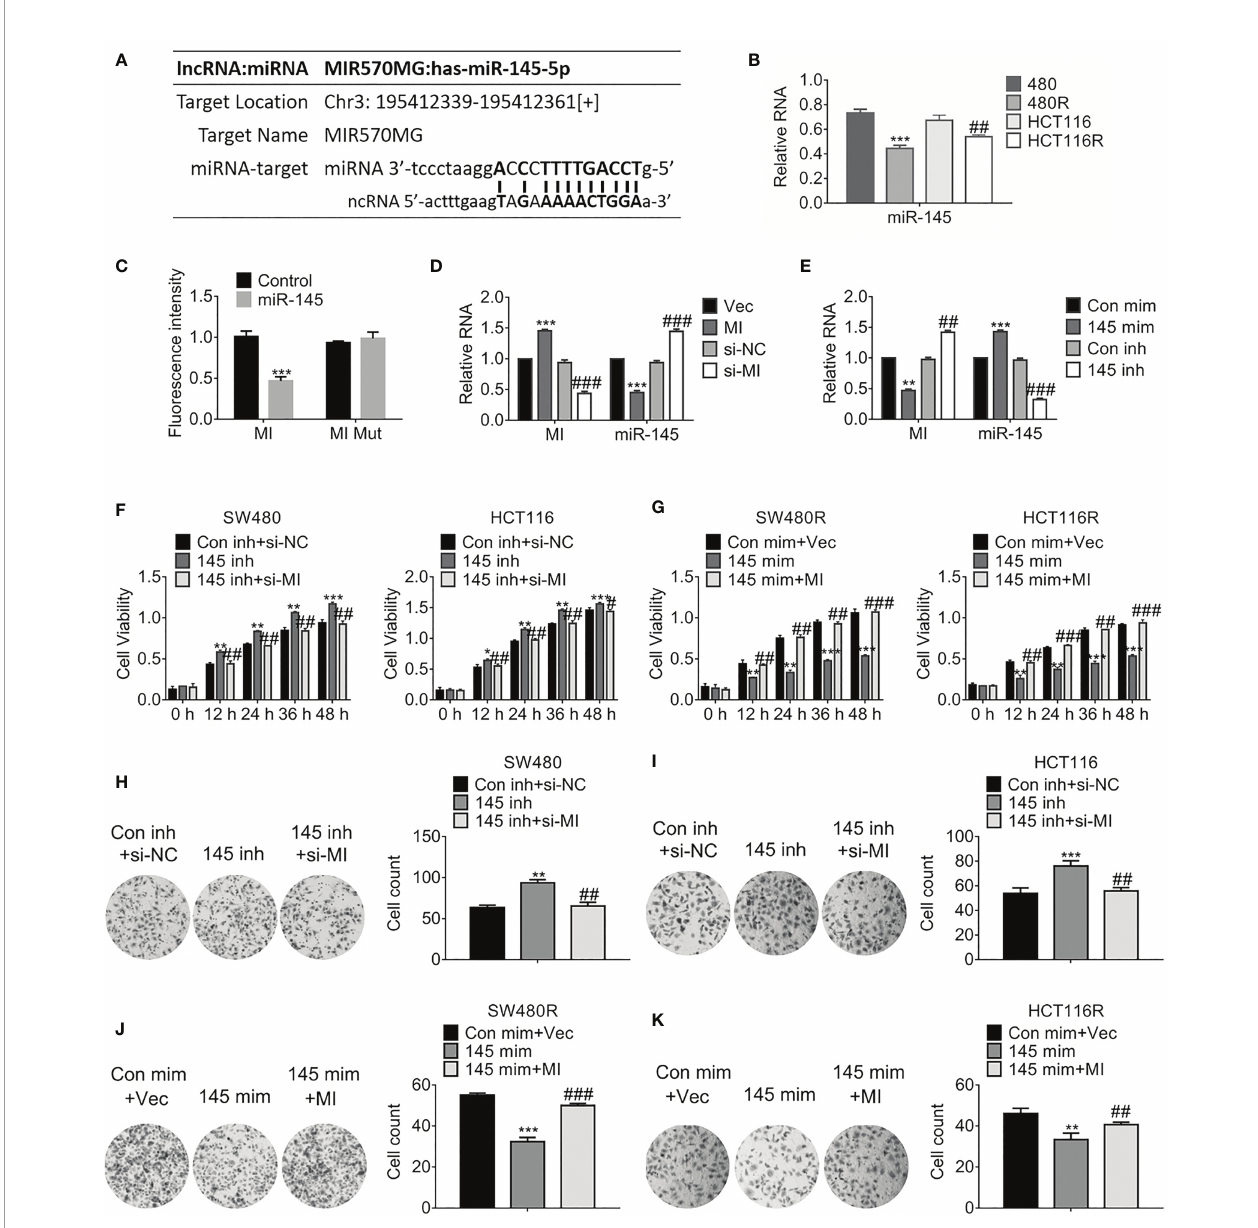
FIGURE 3 | MIR570MG sponges miR-145 and reverses miR-145-mediated growth suppression. (A) Schematic diagram of putative binding sites between MIR570MG and miR-145. (B) Expression of miR-145 in the indicated cell lines. **P < 0.01, vs. SW480; ## P < 0.01, vs. HCT116. (C) Dual-luciferase activity of miR-145 promoter. MI, wild type MIR570MG; MI Mut, MIR570MG mutant. ***P < 0.001, vs. control. (D) Expression of the indicated RNA in cells expressing MIR570MG or si-MIR570MG. ***P < 0.001, vs. vector; ### P < 0.001, vs. si-negative control. (E) Expression of the indicated RNA in cells expressing miR-145 mimic or miR-145 inhibitor. **P < 0.01, ***P < 0.001, vs. control-mimic; ## P < 0.01, vs. control-inhibitor. (F) Viability of SW480 and HCT116 cells was accessed by MTT assay at the indicated time-points. *P < 0.05, **P < 0.01, ***P < 0.001, vs. control; # P < 0.05, ## P < 0.01, vs. miR-145 inhibitor. (G) Viability of SW480R and HCT116R cells was accessed by MTT assay at the indicated time-points. **P < 0.01, ***P < 0.001, vs. control; ## P < 0.01, ### P < 0.001, vs. miR-145 mimic. (H, I) Colony formation of the indicated cells expressing miR-145 inhibitor or miR-145 inhibitor combined with si-MIR570MG. **P < 0.01, vs. control; ## P < 0.01, vs. miR-145 inhibitor. (J, K) Colony formation of the indicated cells expressing miR-145 mimic or miR-145 mimic combined with MIR570MG. ***P < 0.001 vs. control; ## P < 0.01 vs. miR-145 mimic. Data represents mean ± SD of three individual experiments. Vec, vector; MI, MIR570MG; si-NC, negative control; si-MI, si-MIR570MG; Con mim, control mimic; 145 mim, miR-145 mimic; Con inh, control inhibitor; R, Reg, 1 m M regorafenib